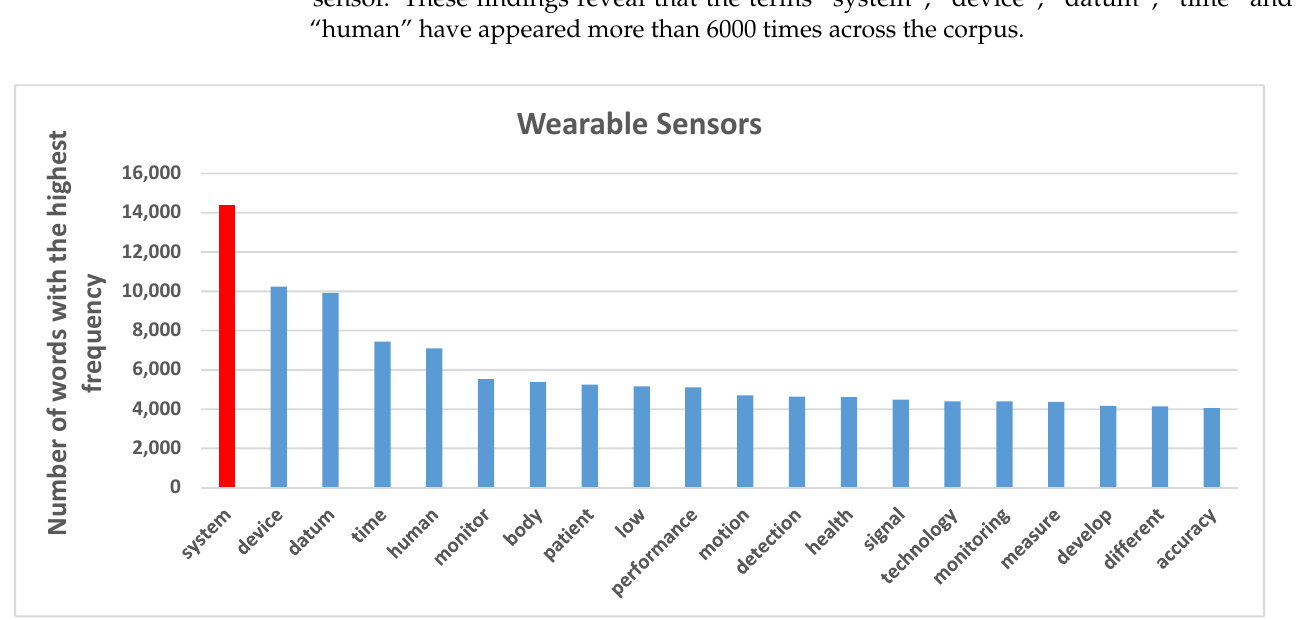
Number of Topics